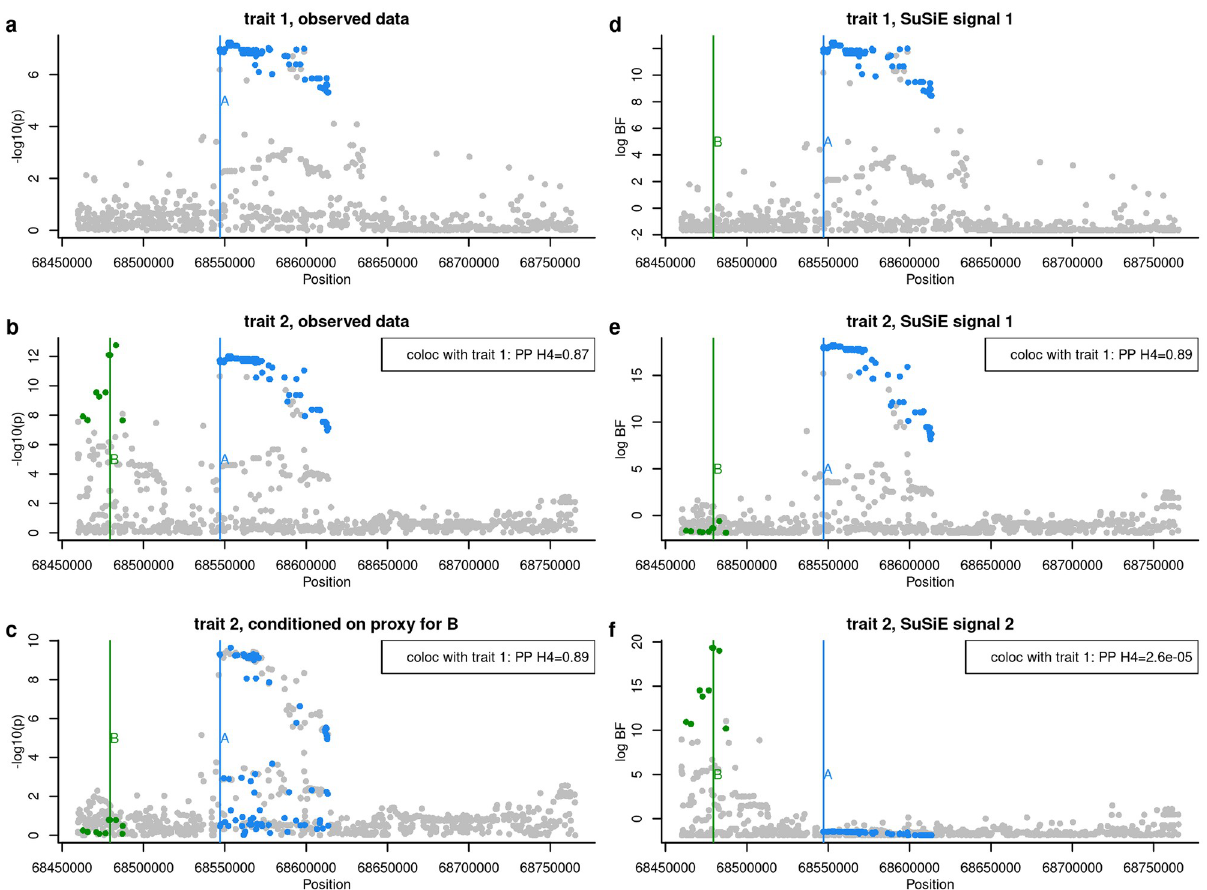
Fig 3. Example where the conditional coloc approach, run in iterative mode, finds misleading results. a and b show the “observed” data (simulated from 1000 SNPs with MAF > 0.01) as -log 10 p values for traits 1 and 2 respectively. Trait 1 has one causal variant, A, and trait 2 has two, A and B. Conditioning identifies a second independent signal for trait 2, and the results of conditioning on the strongest signal is shown in c . Coloc comparisons are based on ( a , b ) and ( a , c ) and both find the posterior probability (PP) of the shared causal variant hypothesis H 4 is > 0.8. SuSiE analysis of the same data finds one credible set in trait 1, and log 10 Bayes factors (BF) for this are shown in d . It finds two credible sets for trait 2, and the log 10 BF for these are shown in e and f . Coloc comparisons are based on ( d , e ) and ( d , f ) and find PP of H 4 of > 0.9 and < 10 − 4 respectively. Blue and green points are used to highlight SNPs in LD with ( r 2 > 0.8) the true causal variants A and B respectively. The data underlying this figure are available in S1